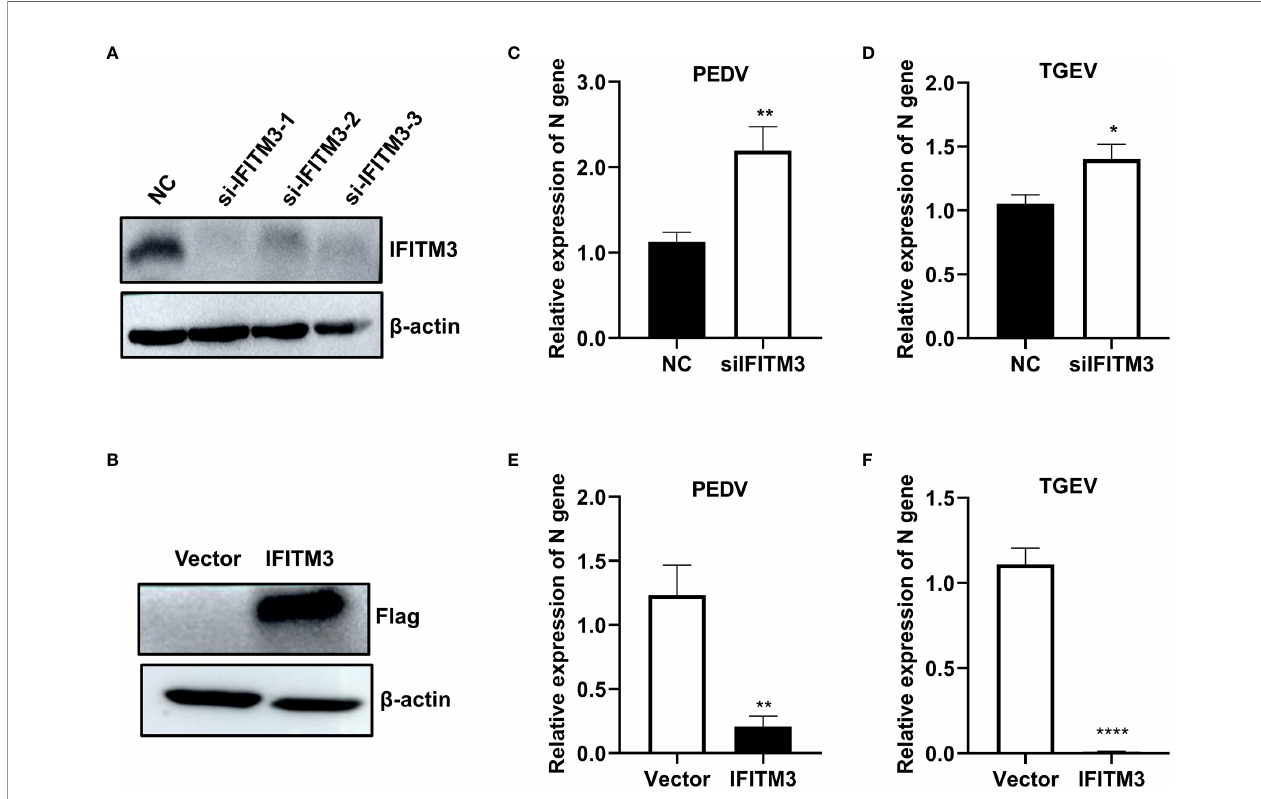
FIGURE 7 | Evaluation of PEDV and TGEV in IFITM3-overexpressed and knocked-down cells. Porcine IPEC-J2 cells were transfected with si-ssc-IFITM3s or pLV-sIFITM3-Flag for 48 h, followed by infection with PEDV or TEGV (MOI = 1). The expressions levels of sIFITM3 were evaluated by Western blot at 48 h post- transfection (A, B) , and the levels of viral genes were quanti fi ed at 24 h postinfection using real-time PCR (C – F) . (A, C, D) IPEC-J2 cells transfected with siIFITM3s. (B, E, F) IPEC-J2 cells transfected with pLV-sIFITM3-Flag. Unprocessed original images are found in Supplementary Figure S2 . *, p-value <0.05; **, p-value <0.01; ****, p-value